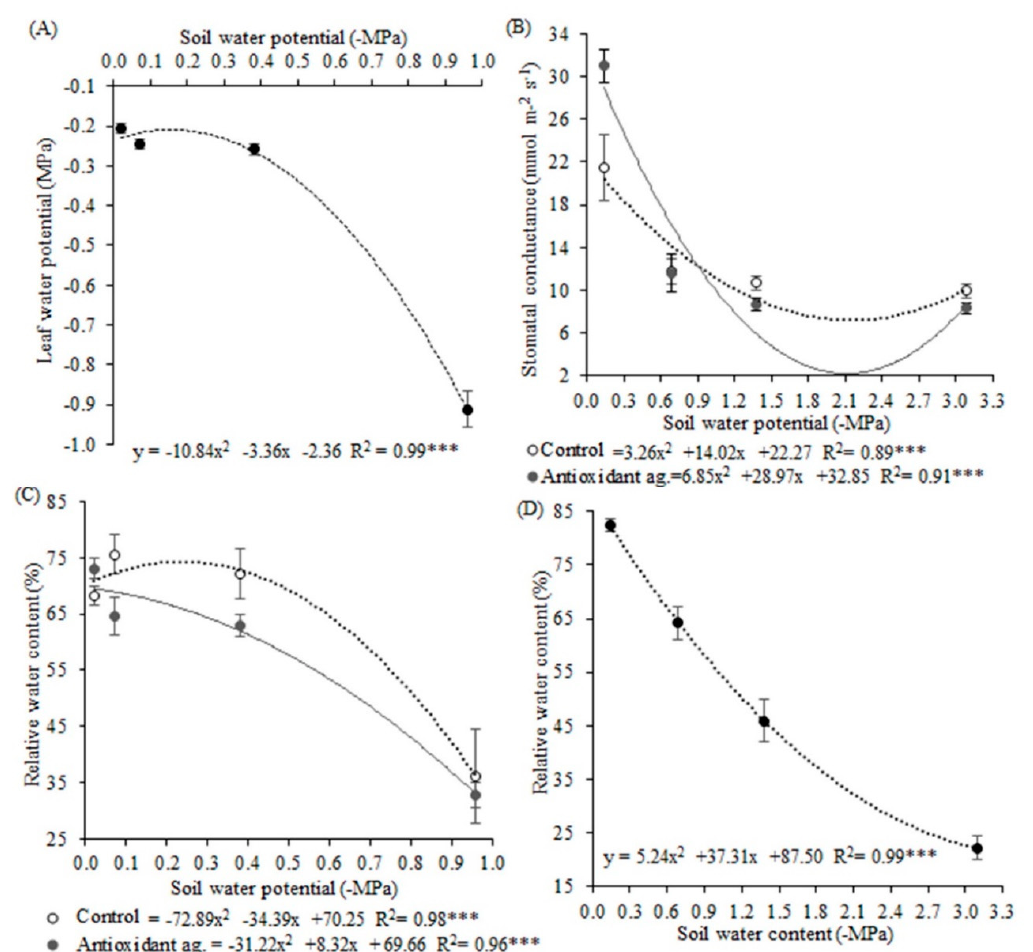
Figure1. Leafwaterpotential( A );stomatalconductance( B );relativewatercontentinthefirstexperiment Figure 1. Leaf water potential ( A ); stomatal conductance ( B ); relative water content in the first ( C )andthesecondexperiment( D )ofsoybeanplantsunderdi ff experiment ( C ) and the second experiment ( D ) of soybean plants under different soil water potentials and antioxidant agent application. Note: asterisks indicate error probability as * = 10%, ** = 5%, and *** = 1%, respectively. Vertical bars represent the standard error of the samples. Analysis of leaf water potential and stomatal conductance were made with transformed data. Leaf water potential data were transformed by cubic root, and stomatal conductance data were transformed by a logarithmic function.